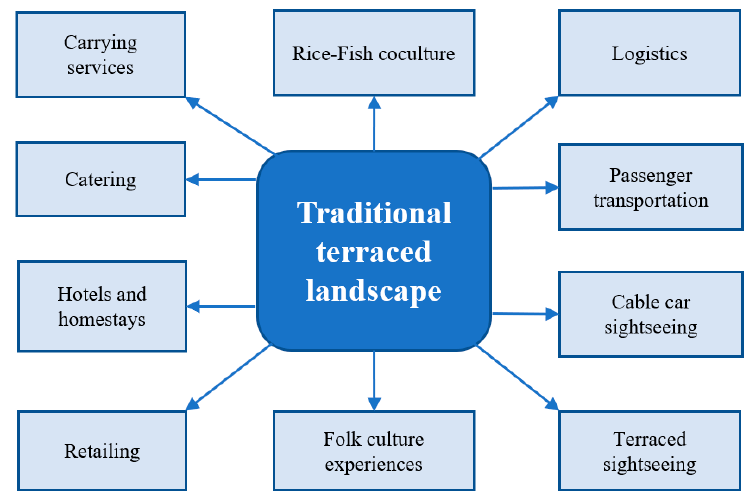
Figure 9. the industrial Chain of Longji Terraces. Figure 9. The industrial Chain of Longji Terraces.